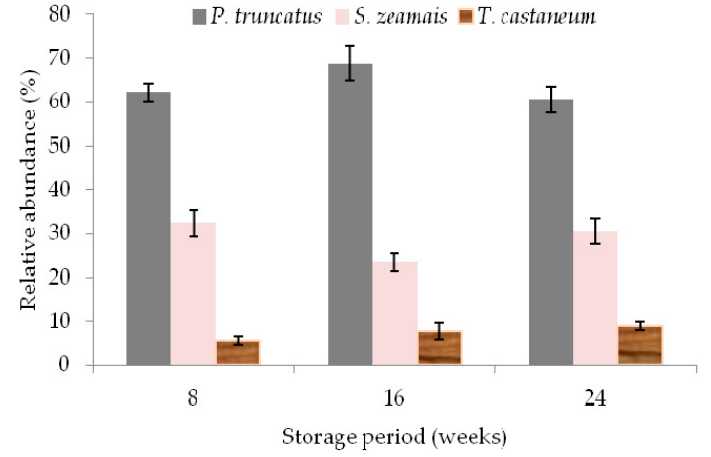
Figure 3. The percentage of insect species abundance across the treatments. Table 4. E ff ect of treatment and storage period on percentage grain damage of maize stored for up to 24 weeks at the Kiboko KALRO research station in Kenya.